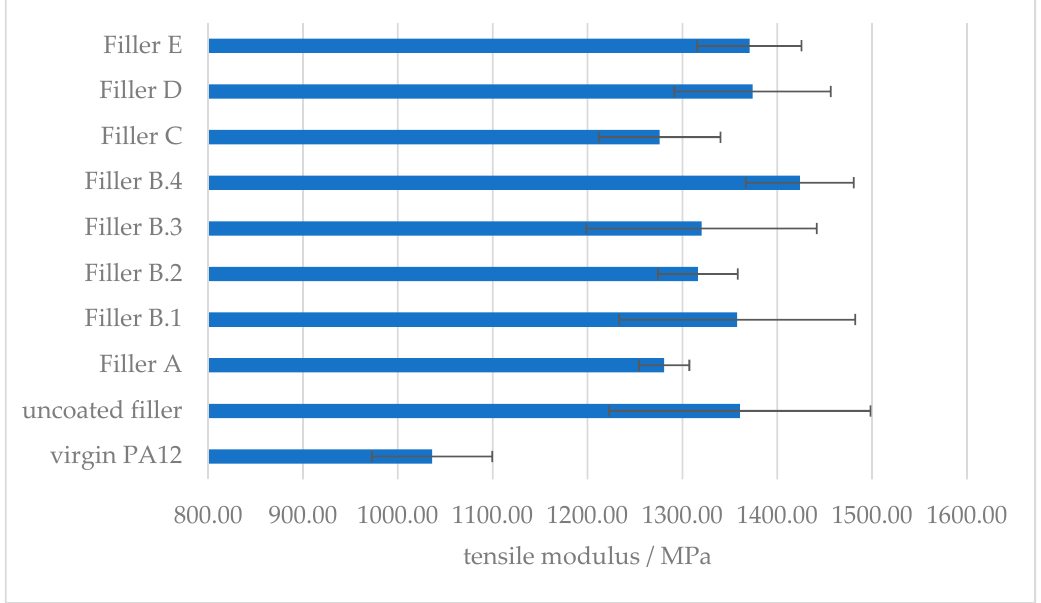
Figure 7. Effect of the amount of surface modifier on the tensile modulus of amino hexanoic acid treated CaCO 3 -filled PA12 composites.